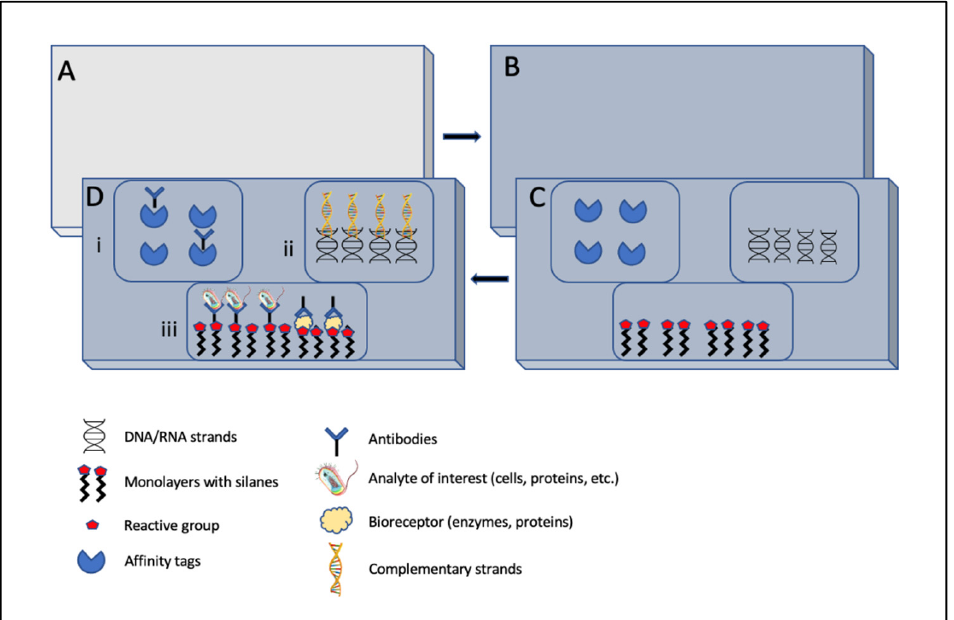
Figure 6. Schematic illustration of key biofunctionalization strategies for the fabrication of optical biosensors. ( A ) Cleaning of biosensor surface (grey surface). ( B ) Chemical activation of sensor surface (blue)—commonly used materials include silicon, its oxides, or nitrides, which use the silane chemistry to functionalize high-class optical transducers. ( C , D ) ( i ) Immobilization of bioreceptors on the treated surface, which can be affinity tags like protein A, a streptavidin biotinylated surface that attaches to selective antibodies; ( ii ) covalent immobilization (DNA-/RNA-based probes), which reacts with complementary strands; ( iii ) self-assembled monolayers with organosilanes to react with specific antibodies for covalent-based protein or analyte detection or hydrophilic monolayers with pegylated silanes or dextran-based molecules with covalently immobilized proteins for antibody detection. Image adapted with permission from [81], Copyrights (2011), John Wiley and